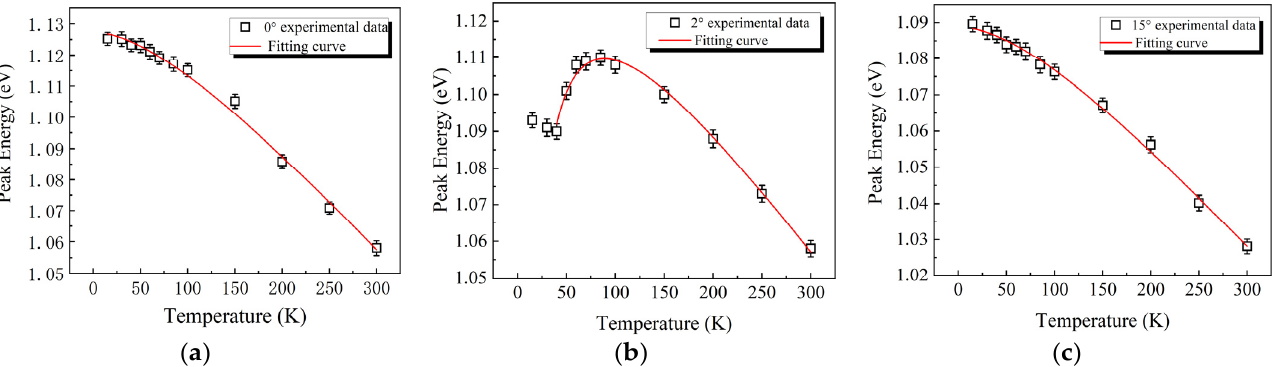
Figure 6. Temperature-dependent of PL spectra for InGaAs/GaAsP QWs on ( a ) 0°, ( b ) 2°, and ( c ) 15° misoriented sub- strates.